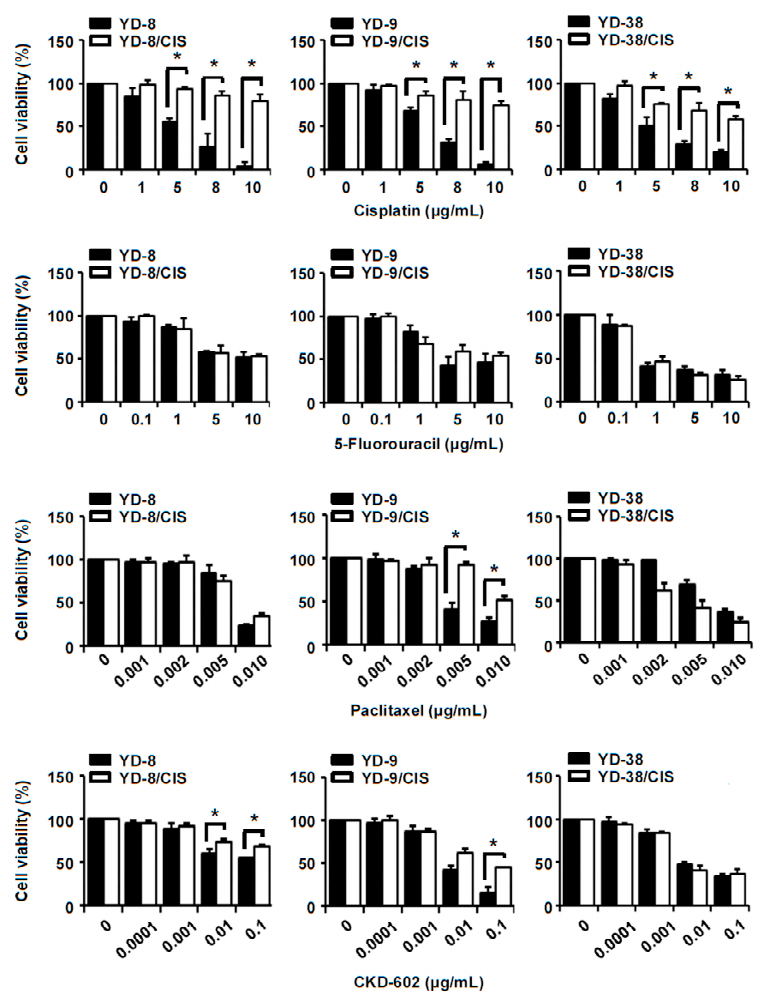
Figure 1. The e ff ect of anticancer drugs on the cell viability of parental and cisplatin-resistant oral squamous cell carcinoma (OSCC) cell lines. YD-8, YD-8 / CIS, YD-9, YD-9 / CIS, YD-38, and YD-38 /